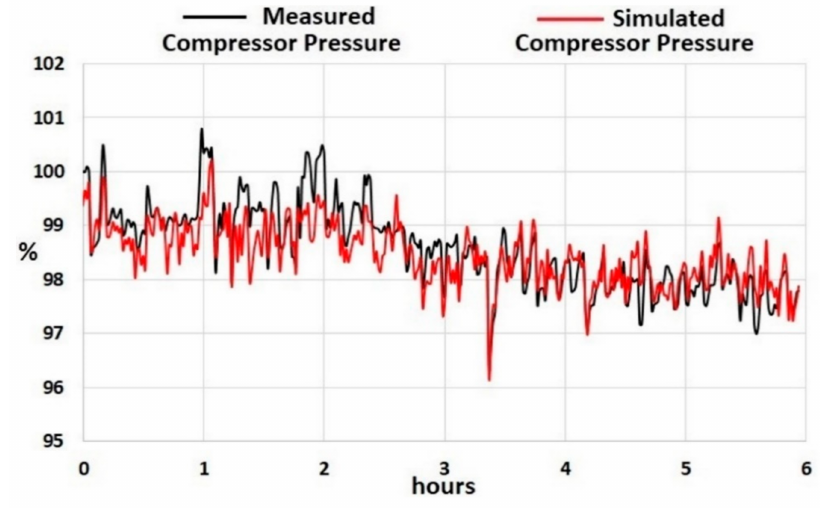
Figure 35. Measured and simulated compressor discharge pressures at low IGV